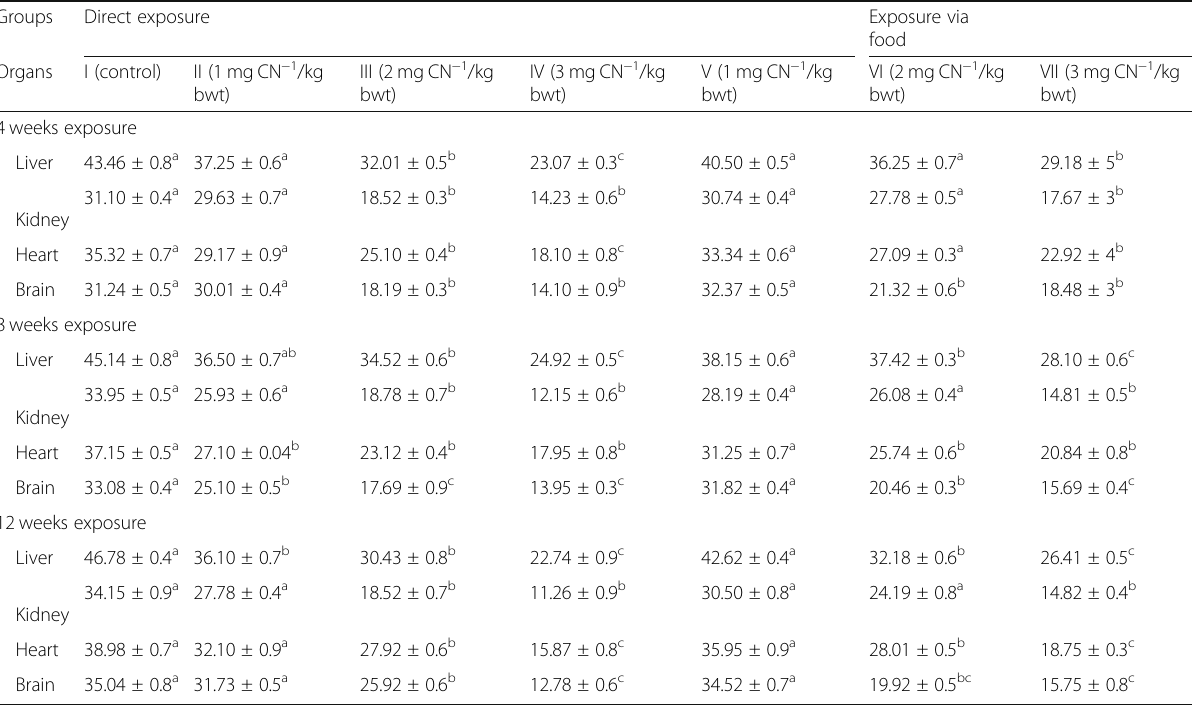
Table 3 The activity of superoxide dismutase (SOD) in some organs of birds exposed to cyanide directly and indirectly in their feed Groups Direct exposure Exposure via